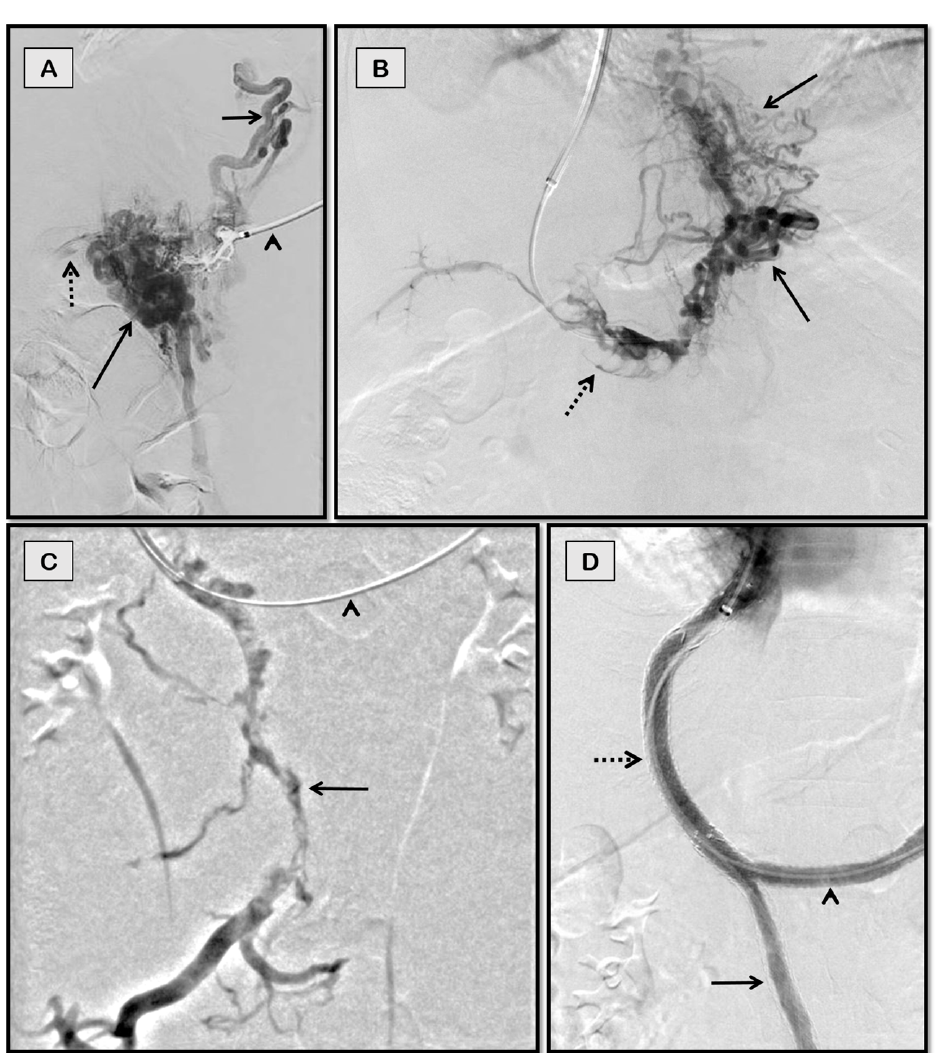
Figure 6. Trans-splenic TIPS for recurrent variceal bleeding in a 63-year-old man with non-cirrhotic chronic porto-mesenteric and splenic vein thrombosis. Fluoroscopic spot image ( A ) of angiogram obtained through trans-splenic route (arrowhead) showing tortuous short gastric vein (short arrow) and perisplenic collaterals (long arrow). Splenic vein is faintly opacified (dashed arrow). Venogram images ( B , C ) captured after obtaining transjugular access through splenic route (arrowhead in C ) showing completely thrombosed portal and superior mesenteric veins (dashed arrow in ( B ) and solid arrow in ( C ), respectively) with varices (solid arrows in B ). Image ( D ) depicts bifurcated Y-shaped stents in splenoportal axis showing brisk flow with disappearance of collaterals.